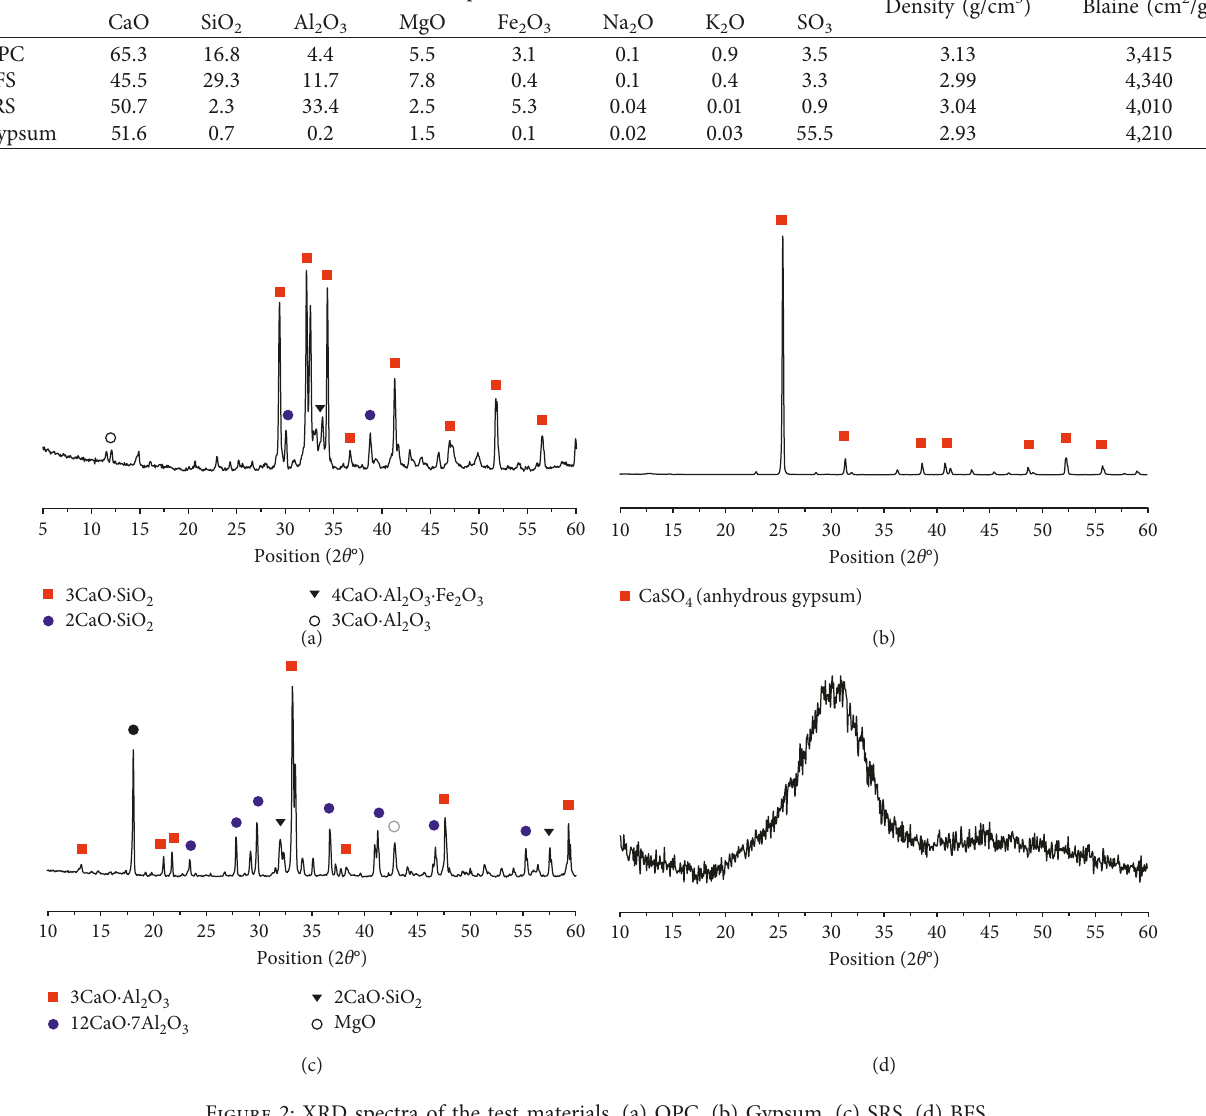
Table 1: Chemical composition and physical properties of the materials. Chemical composition (wt.%)